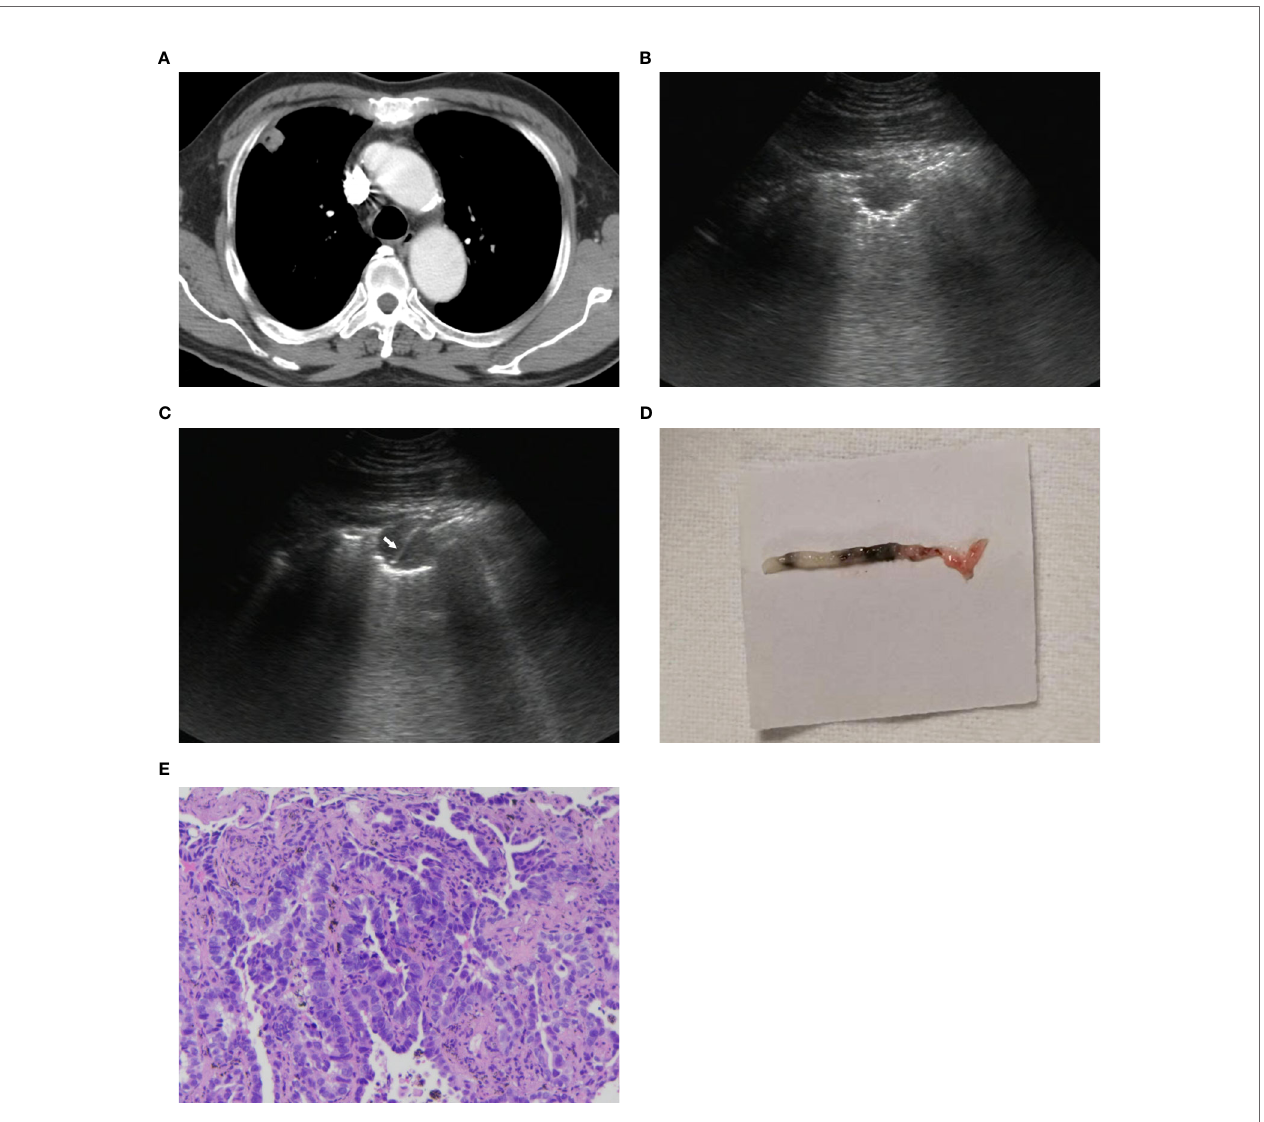
FIGURE 2 | A 67-year-old man with a peripheral lung lesion. Ultrasound-guided percutaneous core needle biopsy was performed. (A) Contrast-enhanced CT image showed a lung lesion located in right upper lobe with pleural contact. The diameter of the lesion was 19 mm. (B) The lesion manifested as low-echoic on baseline ultrasound. (C) The 16-gauge needle track during the biopsy procedure was shown on the image (white arrow). (D) Color photograph of the biopsy sample. (E) Pathological evaluation showed that heterotypic cells were arranged in tubular or adenoid structures (HE staining;